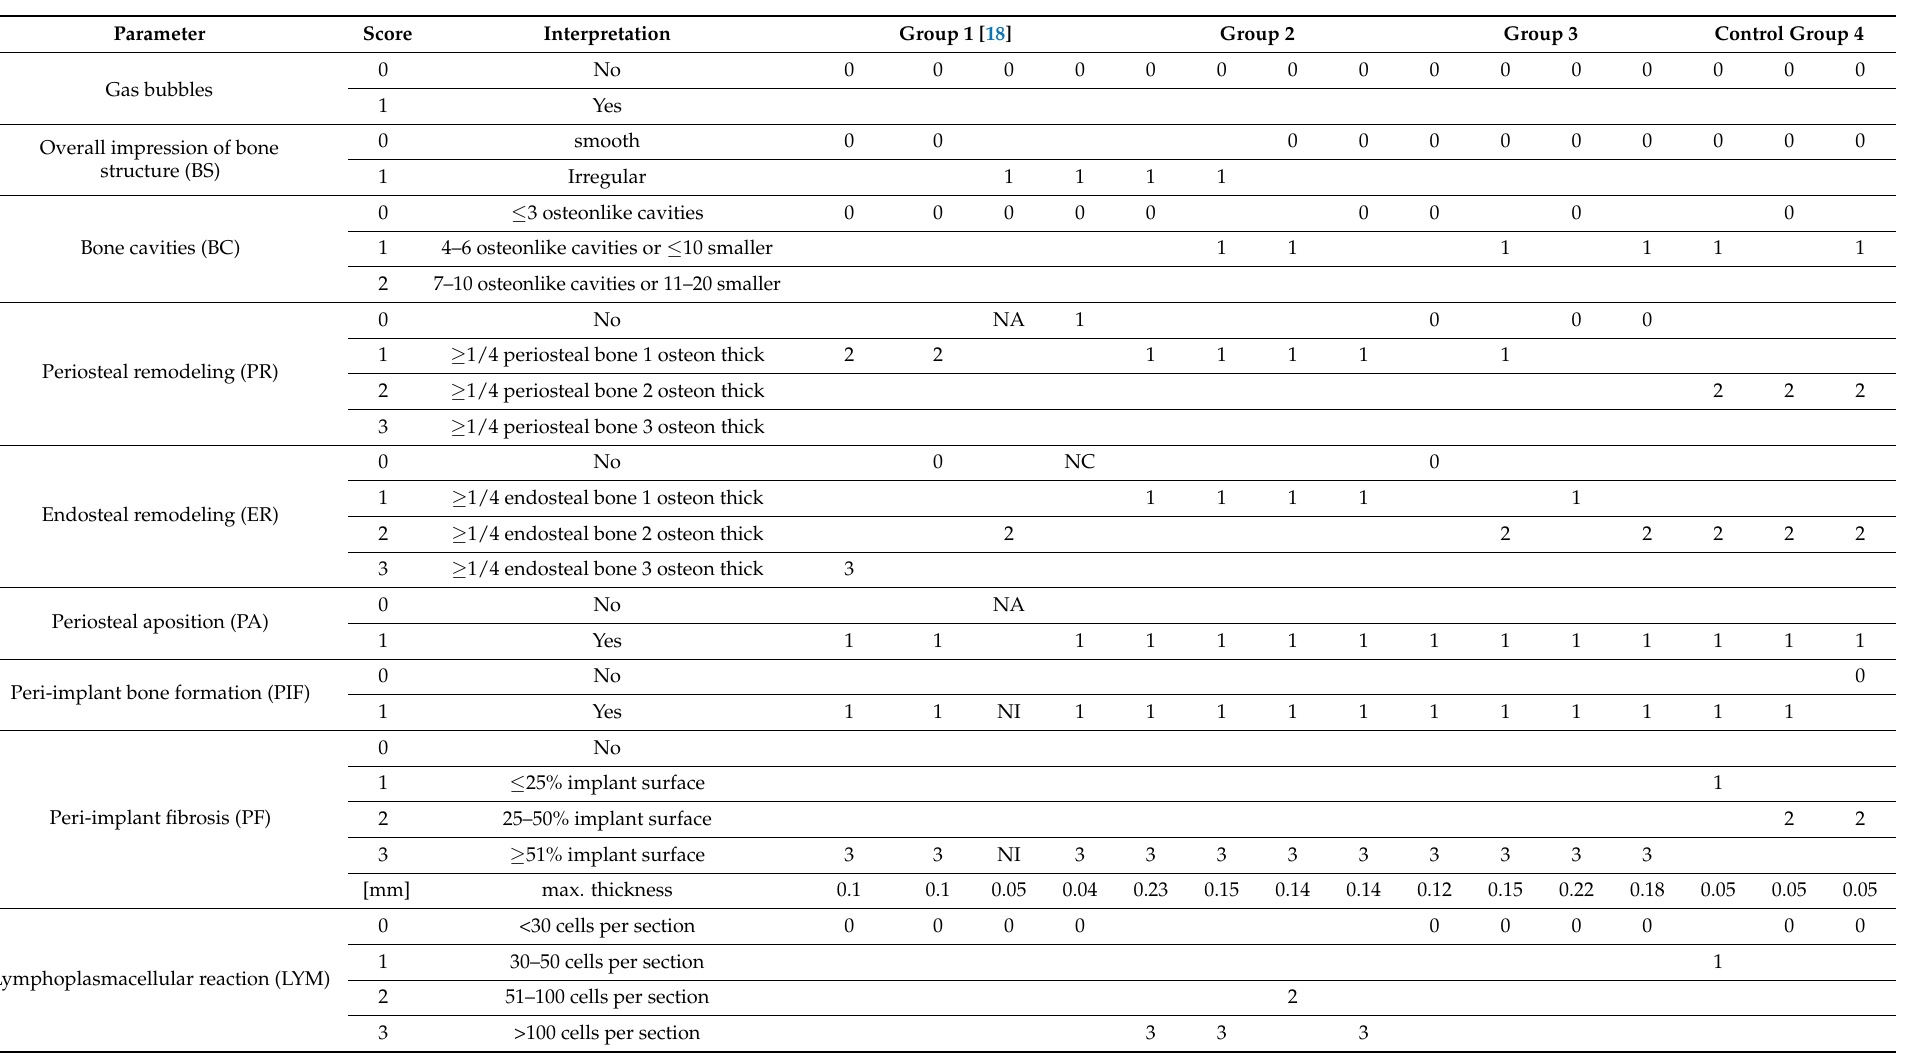
Table 3. Evaluation of the healing process according to the parameters of the histology specimens; bone morphology and cells were assessed with a semi-quantitative scoring system, using the method described by Reifenrath et al. [30]. Note: NA = not applicable, NI = no implant visible, NC = not applicable as screw in compacta.